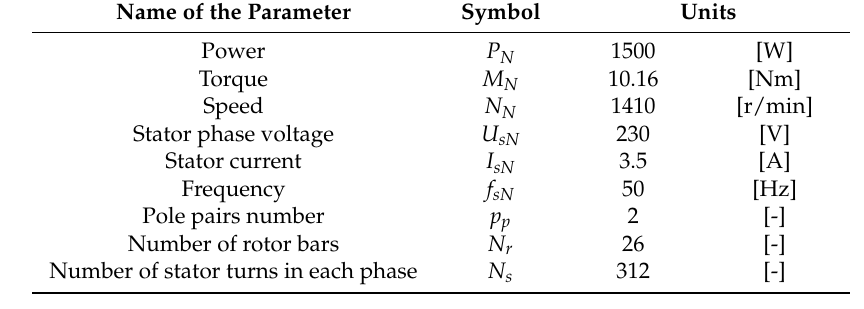
Table 1. Rated parameters of the tested induction motor.